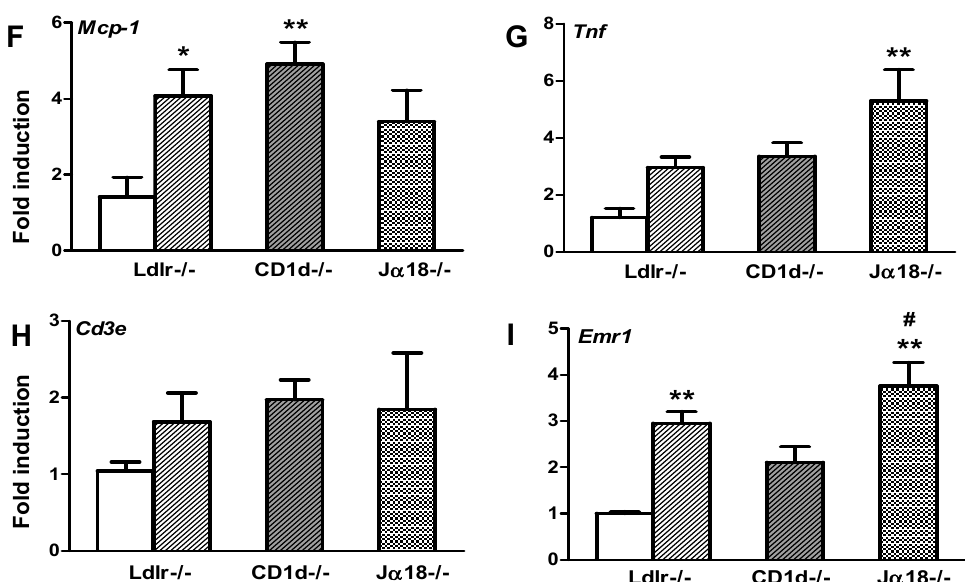
Figure 4. Effects of NKT cell deficiency in liver. ( A ) Liver weights, ( B ) plasma SAA levels, and hepatic triglyceride ( C ), and cholesterol ( D ) content. ( E ) Liver sections stained with Masson’s trichrome, 10 × magnification. ( F – I ) Expression level of genes in whole liver tissue expressed as relative to lean chow-fed Ldlr − / − mice. n = 10 per group. * p < 0.05, ** p < 0.01, *** p < 0.001 vs. corresponding lean group, # p < 0.05 vs. HFHSC-fed Ldlr − / − mice. Solid bars—chow-fed animals; hatched bars—HFHSC-fed animals. SAA: serum amyloid A.